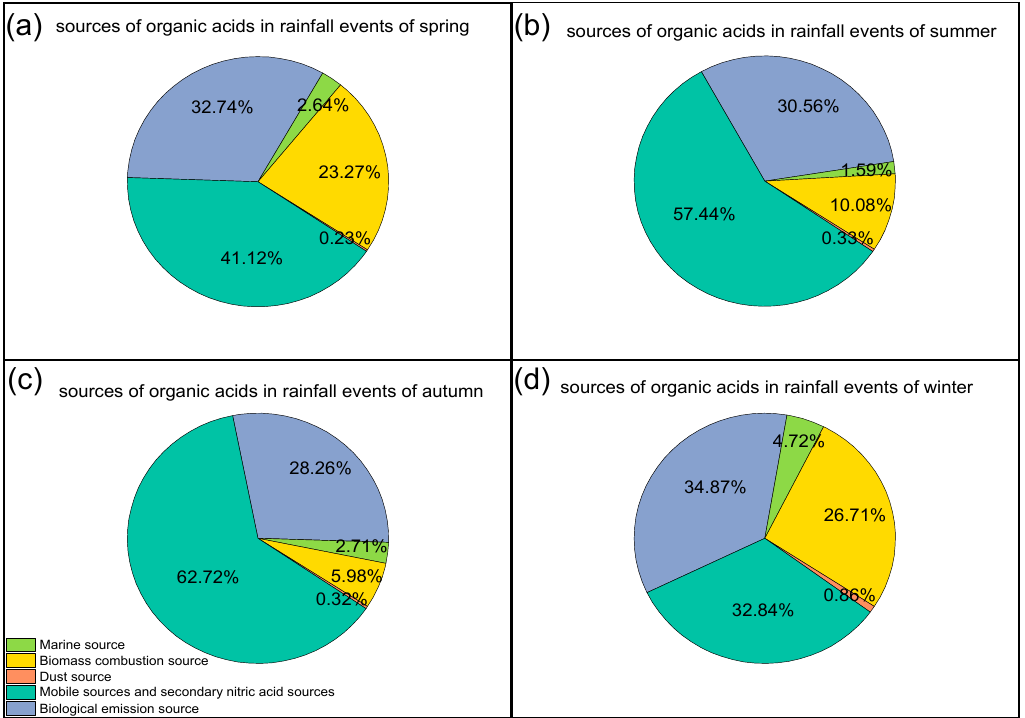
Figure 8. Illustrations of the percentage of factor contributions to organic acids in ( a ) spring, ( b ) summer, ( c ) autumn, and ( d ) winter.